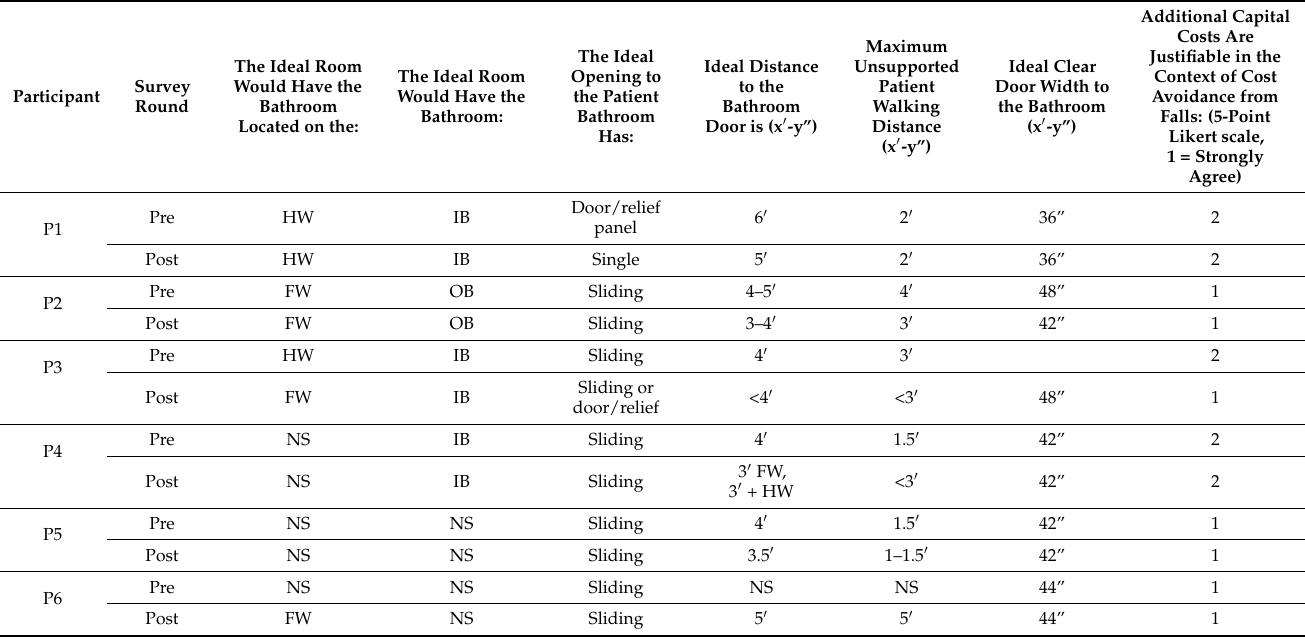
Table 9. Perceptions about room design features and